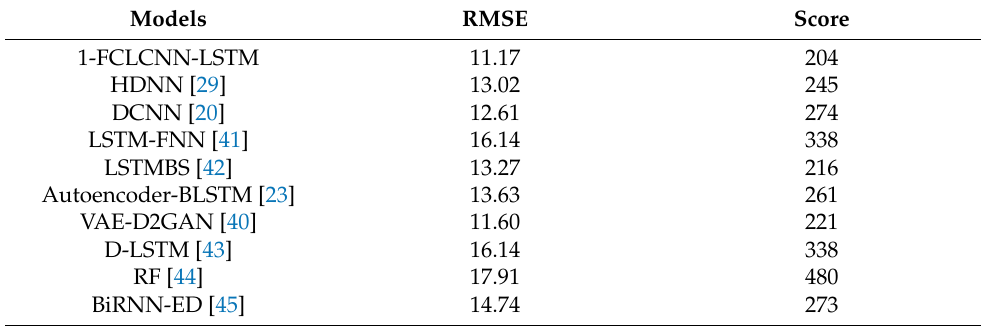
Table 7. Comparison results of various models on the FD001 dataset.